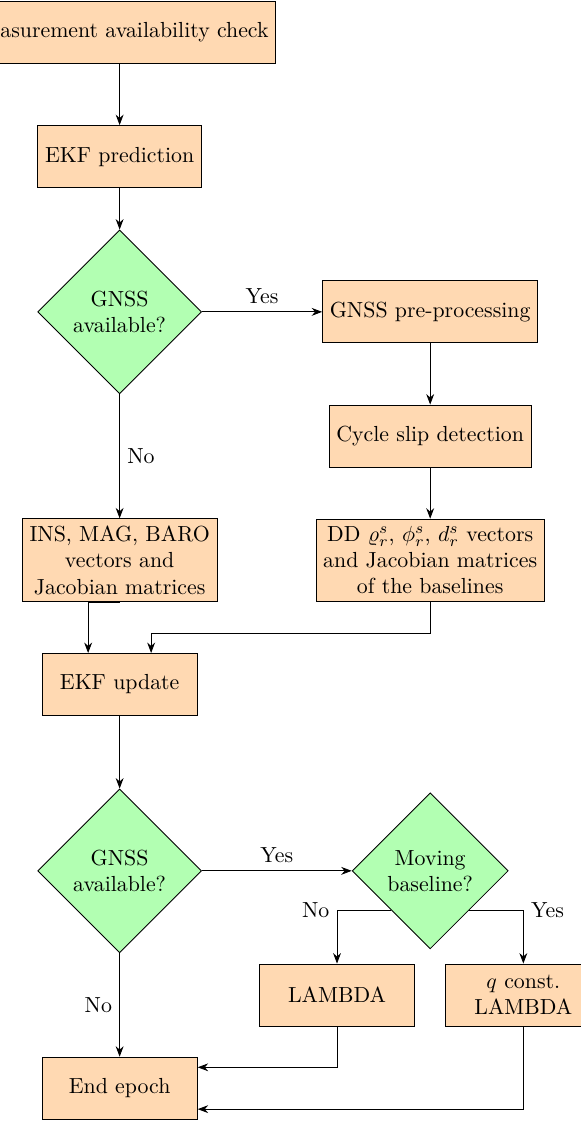
Figure 2. Flowchart of the EKF-based estimation algorithm in a single measurement